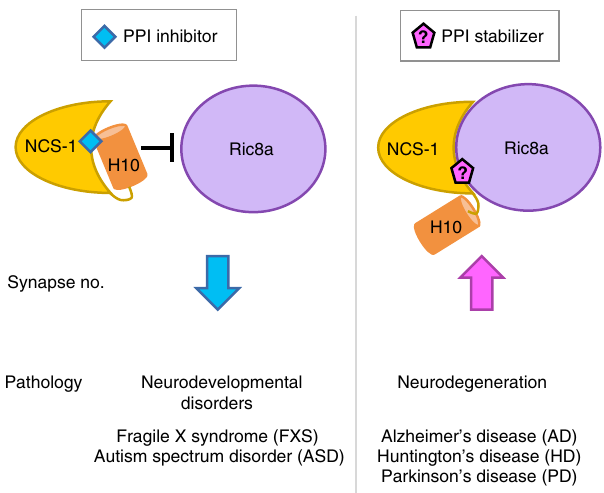
Fig. 1 The complex between NCS-1 and Ric8a as a target for synaptopathies. Schematic representation of the regulation mechanism of the PPI target with small molecules. Examples of pathologies associated with an abnormal synapse number and the modulatory effect (decrease or increase in synapse number) exerted or expected by the small molecule modulators are also given. The key NCS-1 C-terminal helix is represented